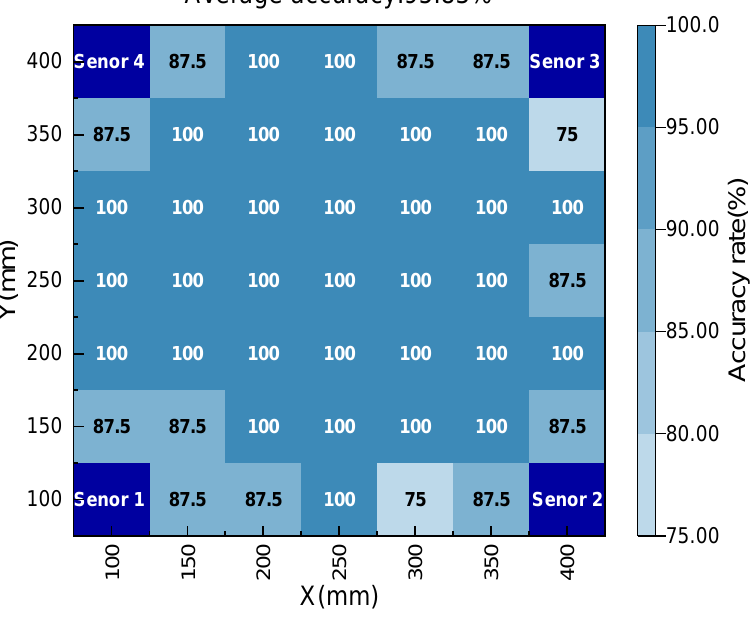
Figure 9. Identification accuracy of DL model on aluminum alloy test set.